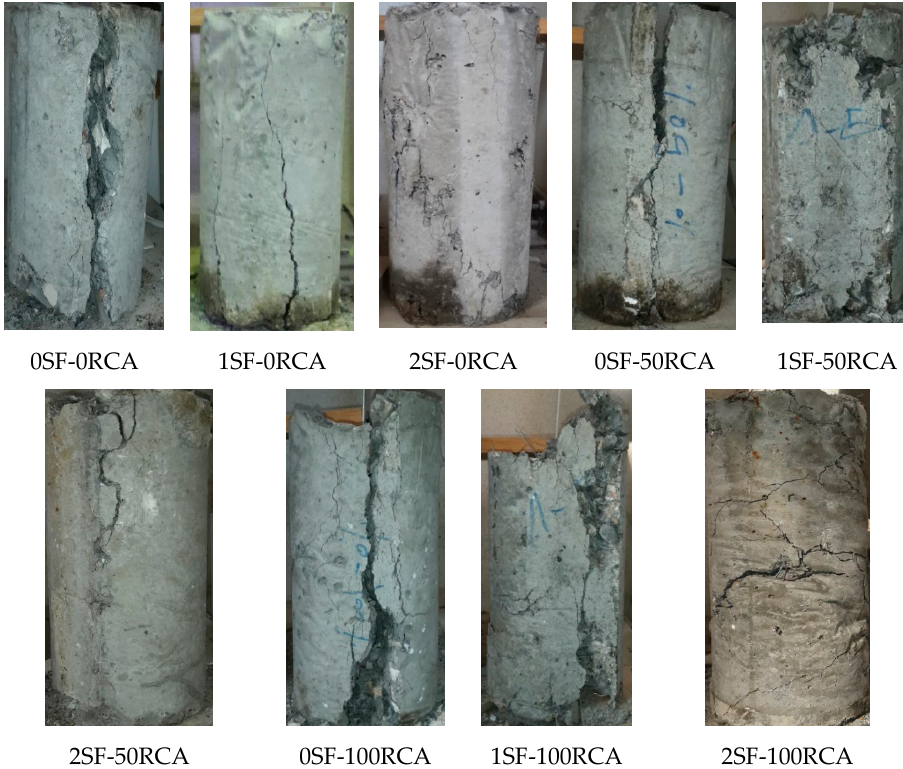
Figure 12. Effects of the SF and RCA contents on the concrete’s tensile behaviour. Figure 12. E ff ects of the SF and RCA contents on the concrete’s tensile